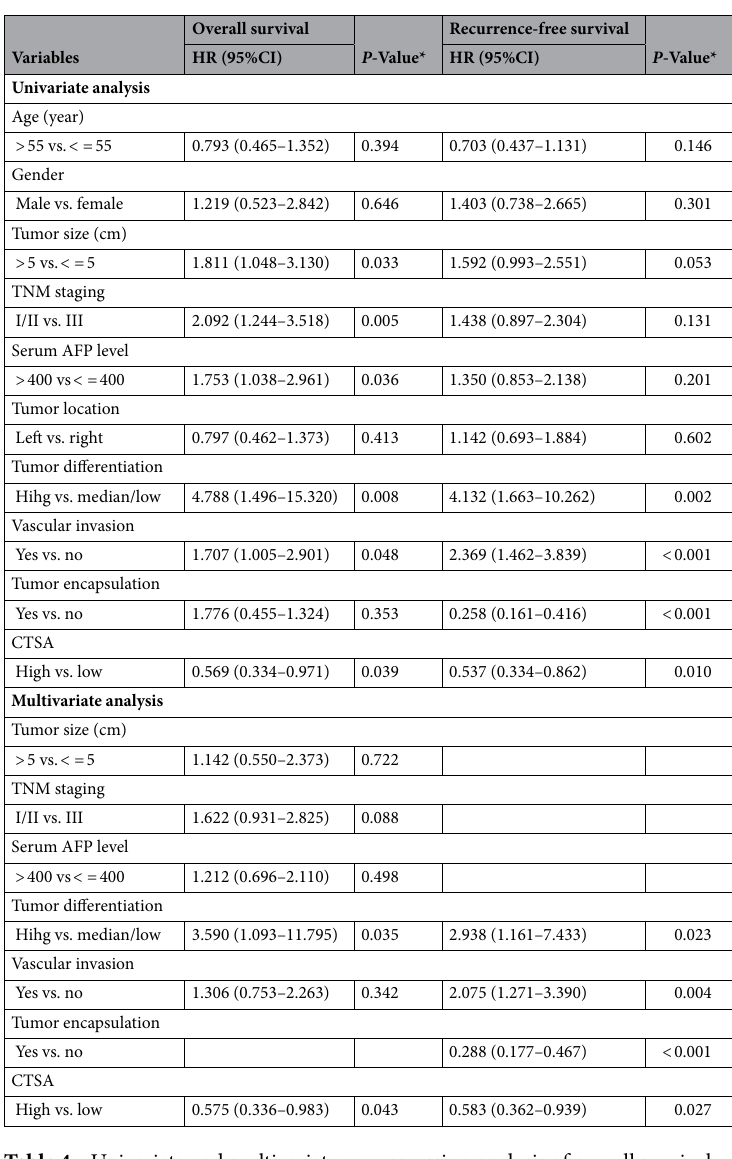
Table 4. Univariate and multivariate cox regression analysis of overall survival and recurrence-free survivalin in HCC patients (n =